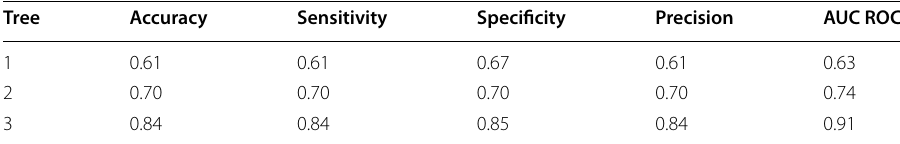
Table 5 Performance of decision trees